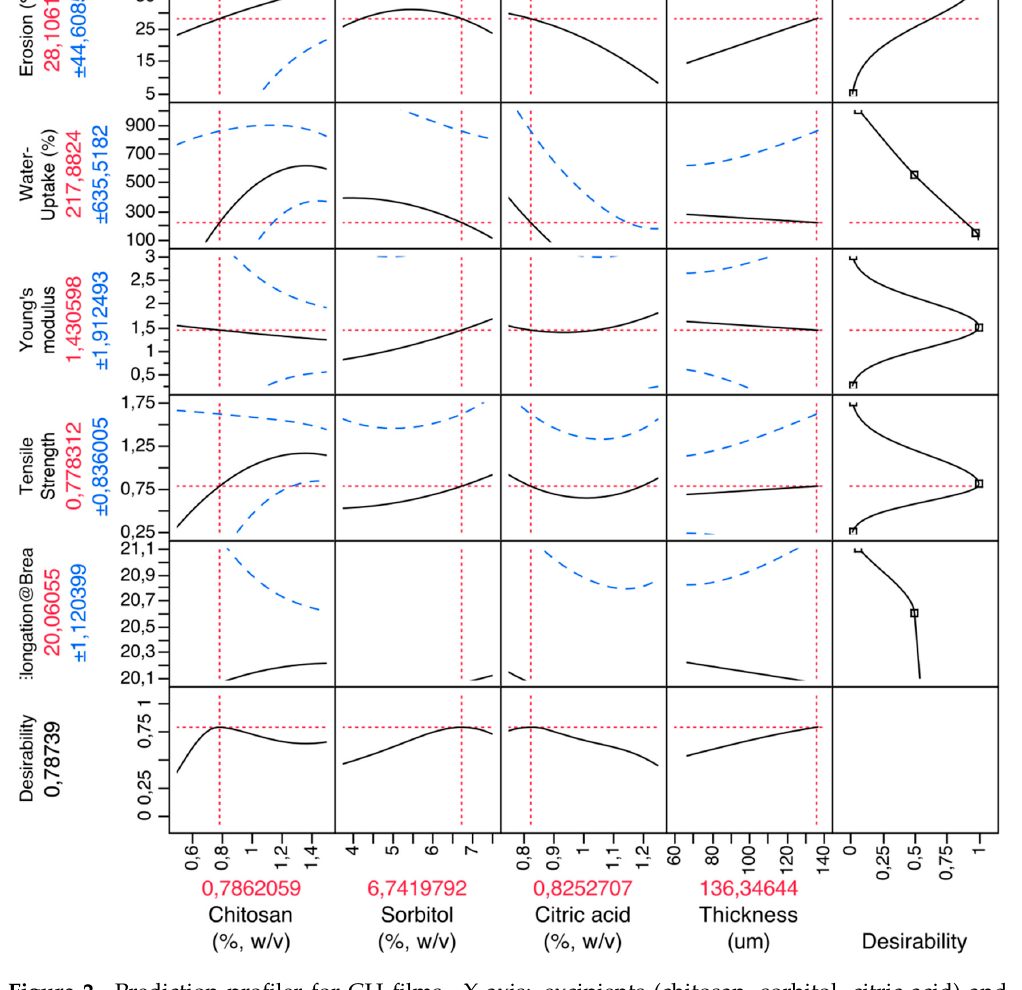
Figure 2. Prediction profiler for CH films. X-axis: excipients (chitosan, sorbitol, citric acid) and thickness; Y-axis: mechanical properties (elongation at break (%), tensile strength (MPa), Young’s modulus (MPa)), water uptake (%) and erosion (%).